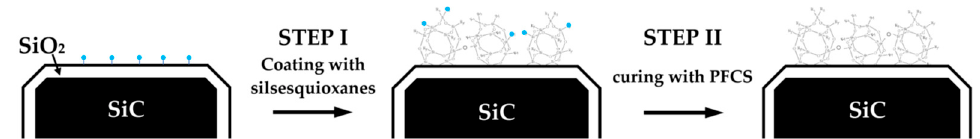
Figure 3. Membrane modification: condensation of the silsesquioxane gel with surface silanols (STEP I), and reaction of the remaining hydroxyls with 1 H ,1 H ,2 H ,2 H -perfluorooctyltrichlorosilane, PFCS (STEP II). Blue dots indicate OH groups.